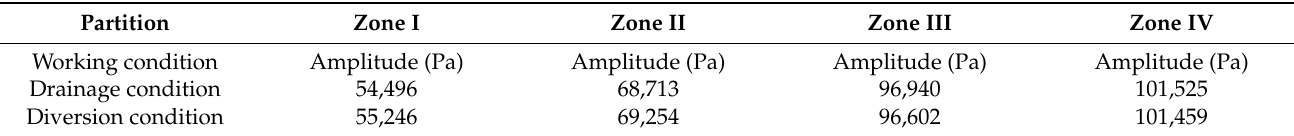
Table 4. Amplitude of zone loading.